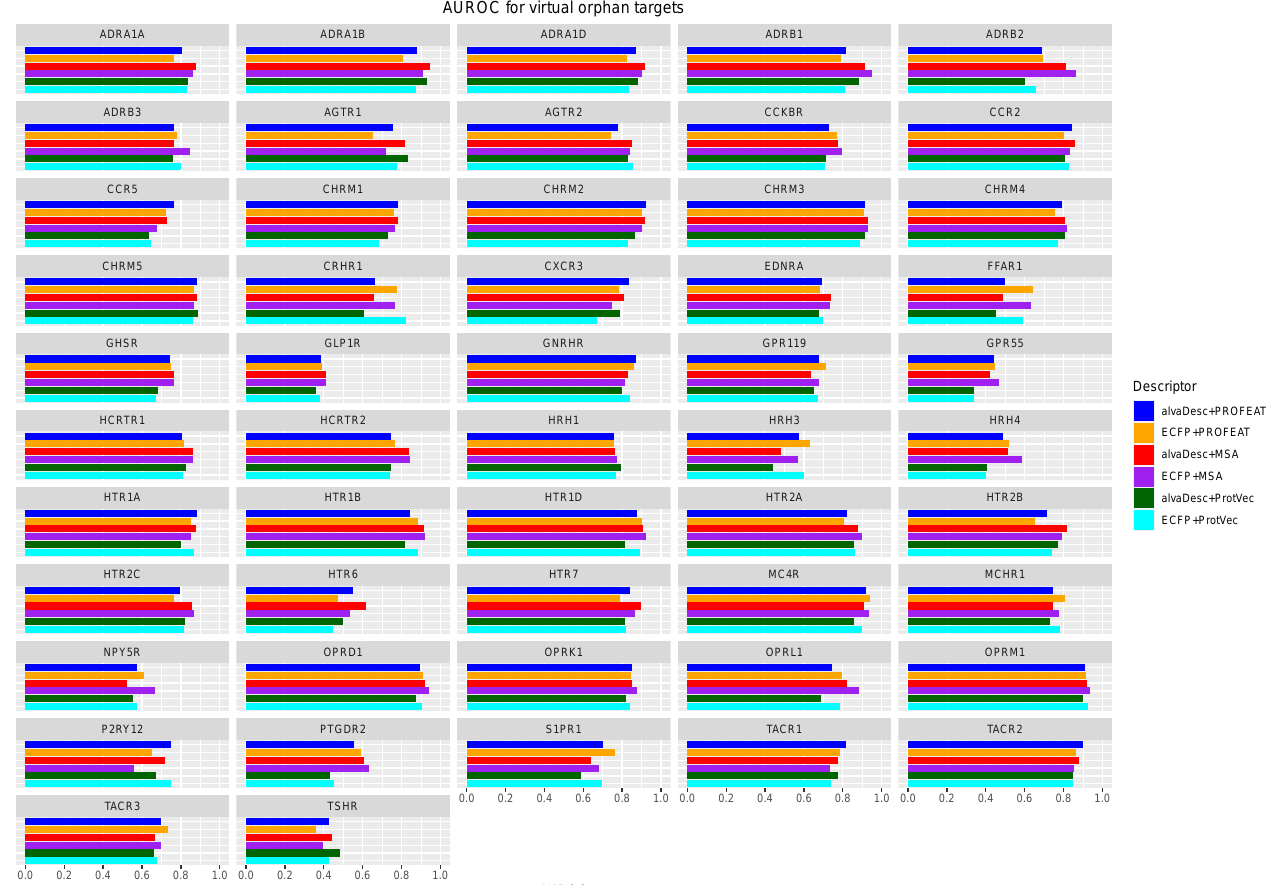
Figure 4. AUROC of the screening calculation results using virtual orphan GPCR models. Red, blue, and green bars indicate the combination of alvaDesc with MSA, PROFEAT, and ProtVec, respectively. Purple, orange, and light blue bars indicate the combination of ECFP with MSA, PROFEAT, and ProtVec,